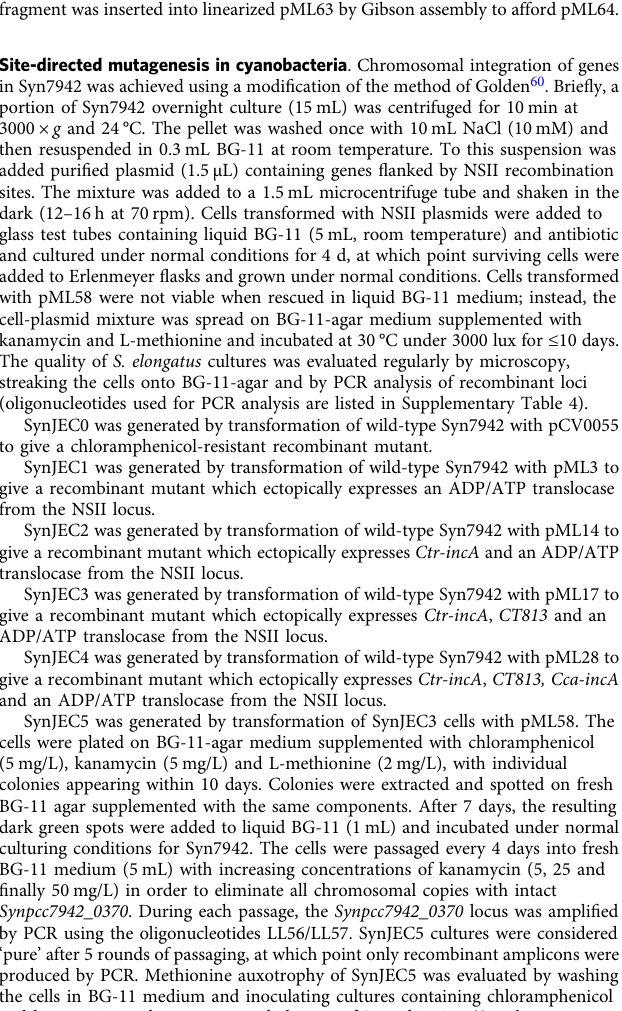
Table 3. pML3: pCV0055 18 was linearized by PCR using the oligonucleotides AM1216/ AM1217. A gBlock of the UWE25-ntt1 gene codon optimized for S. elongatus was ampli fi ed by PCR using the oligonucleotides AM1214/AM1215. The ampli fi ed DNA fragment was inserted into linearized pCV0055 by Gibson assembly to afford pML3. pML14: pML3 was linearized by PCR using the oligonucleotides AM1195/ AM1312. A gBlock of the C. trachomatis incA gene codon-optimized for S. elongatus ( Ctr-incA ) was ampli fi ed by PCR using the oligonucleotides AM1313/ AM1314 and inserted into linearized pML3 by Gibson assembly to afford pML14. pML17: pML14 was linearized by PCR using the oligonucleotides AM1312/ AM1351. A gBlock of the CT_813_CDO-1 gene was ampli fi ed by PCR using the oligonucleotides AM1352/AM1353 and inserted into linearized pML14 by Gibson assembly to afford pML17. pML28: pML17 was linearized by PCR using the oligonucleotides AM1506/ AM1507. A variant of the C. caviae incA gene codon-optimized for S. elongatus ( Cca-incA ) was ampli fi ed by PCR using the oligonucleotides AM1502/AM1503, puri fi ed and ampli fi ed once more using the oligonucleotides AM1504/AM1505. The amplicon was inserted into linearized pML17 by Gibson assembly to afford